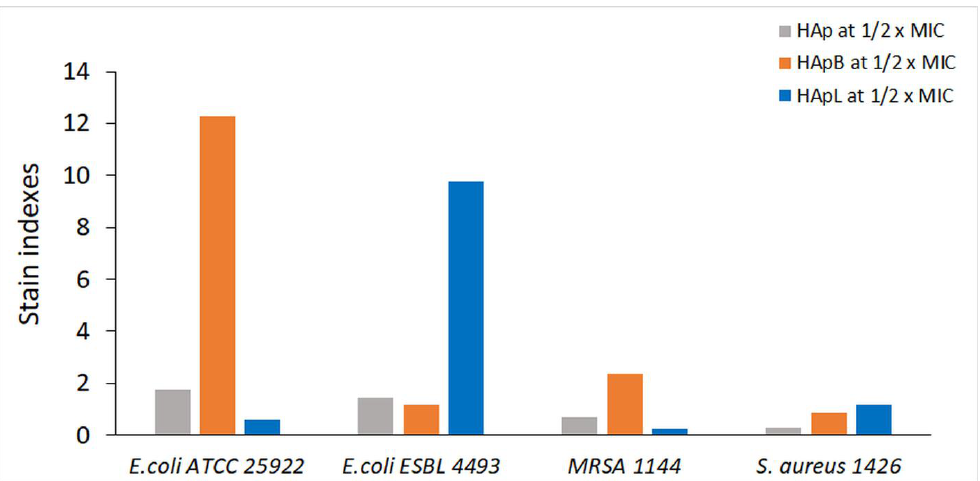
Figure 6. Stain indexes for each tested strain. The stain index is the ratio of the intensity of fluorescence measured in the FITC channel (530/30 nm), of bacteria treated with HAp, HApB and HApL to that of untreated cells.